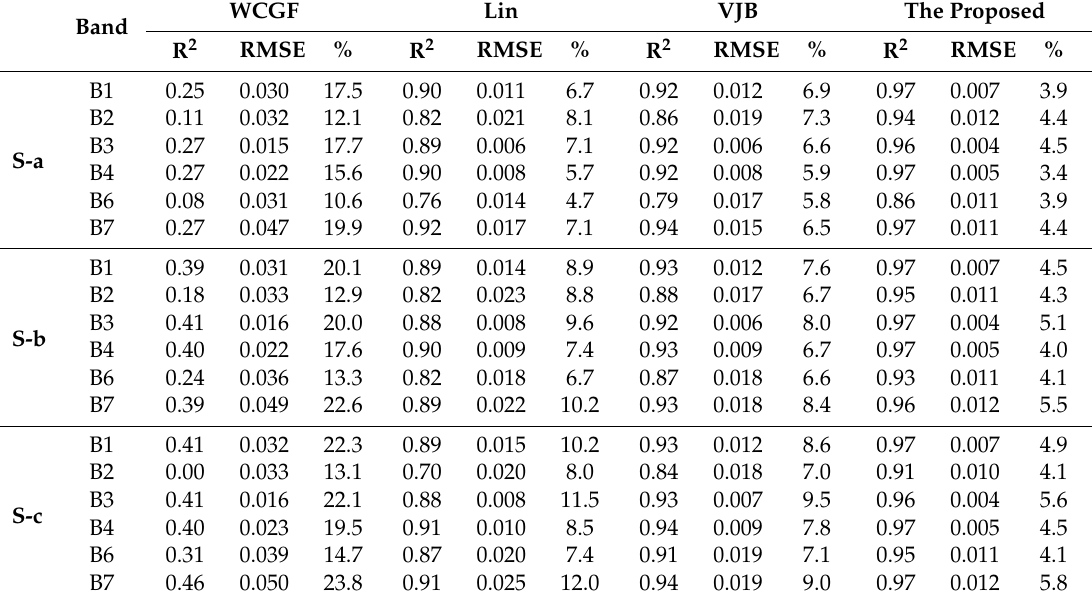
Table 1. Statistics for the retrieved spectral reflectance for MODIS band from the four methods based on the simulating cloud areas in Figure 6a–c (% is the percent of